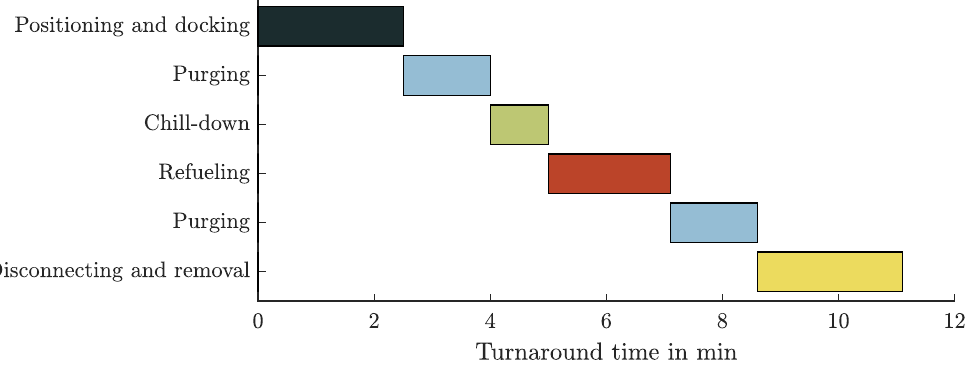
Figure 6. Gantt chart for LH2 refueling of 5350kg; the energy corresponds to the maximum kerosene volume of A320-like